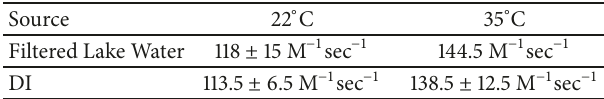
Table 2: Effect of natural lake water on the MC-LA second order rate constant.